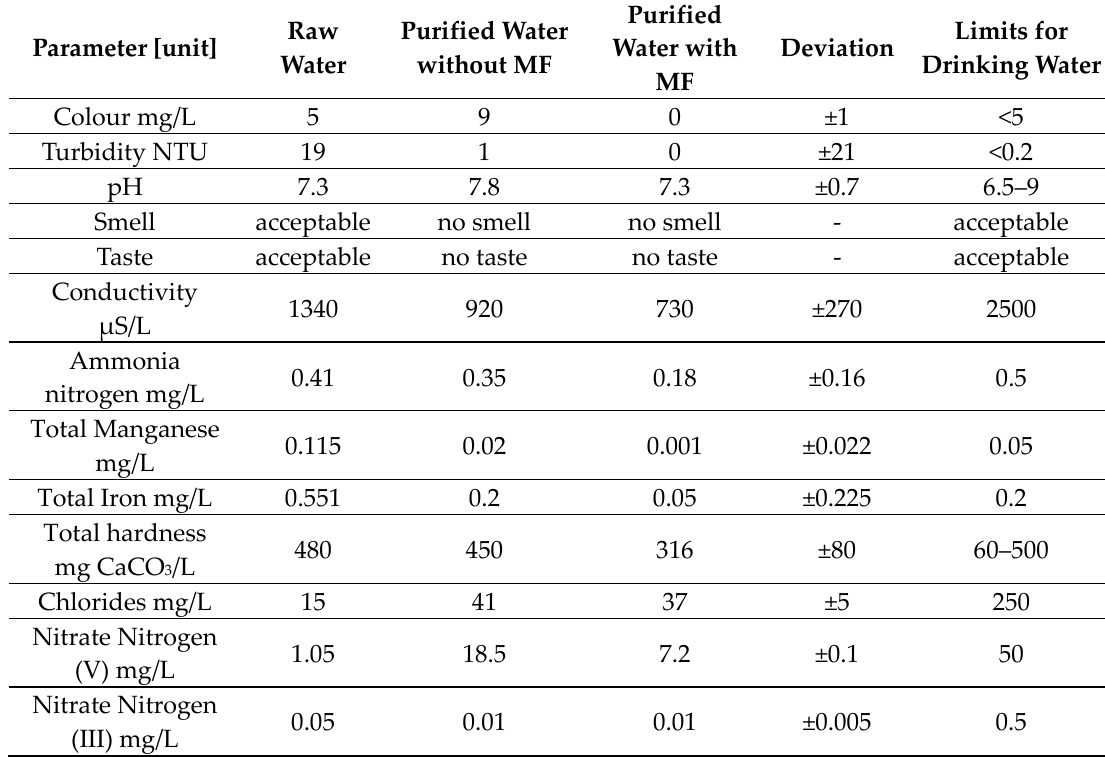
Table 1. Raw and purified water